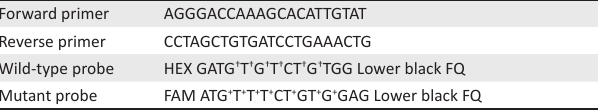
TABLE 1: Polymerase chain reaction primer and probe sequences used to detect the JAK2 V617F mutation (5′ → 3) . Forward primer AGGGACCAAAGCACATTGTAT Reverse primer